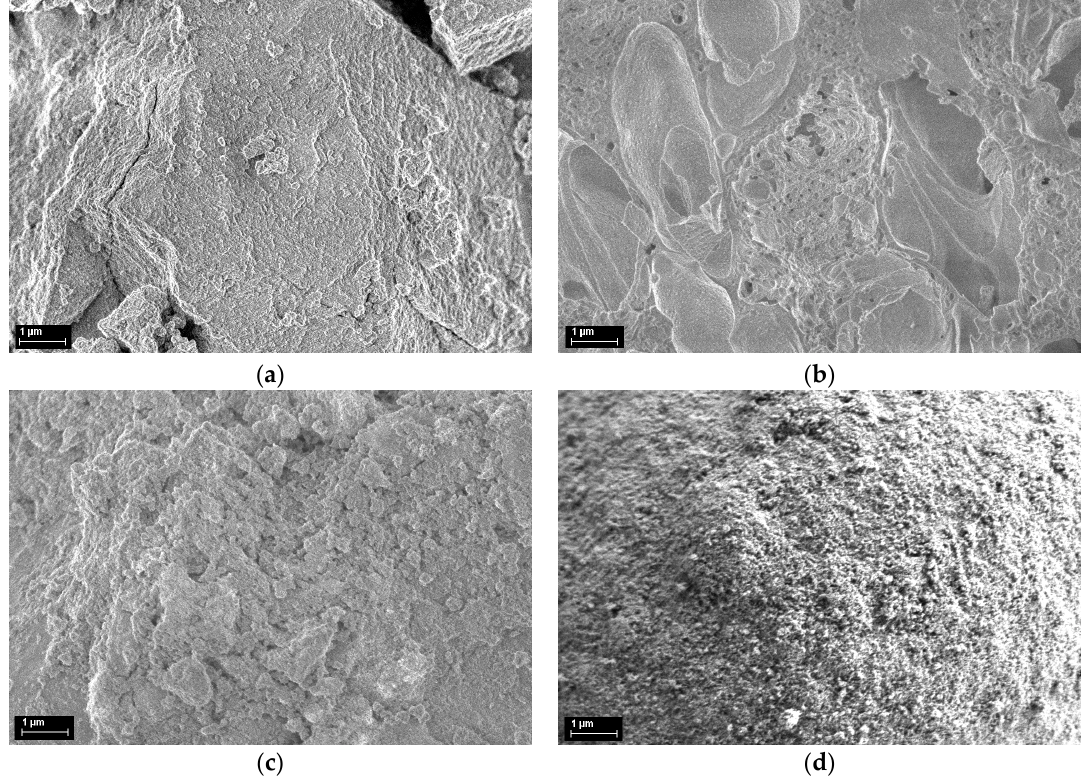
Figure 6. SEM images at 10,000× magnification of the 7Ce3Mn/10LaAl materials prepared by the following methods: ( a ) coprecipitation; ( b ) citrate-based sol-gel; ( c ) impregnation and ( d ) sample Sasol Puralox TH100.